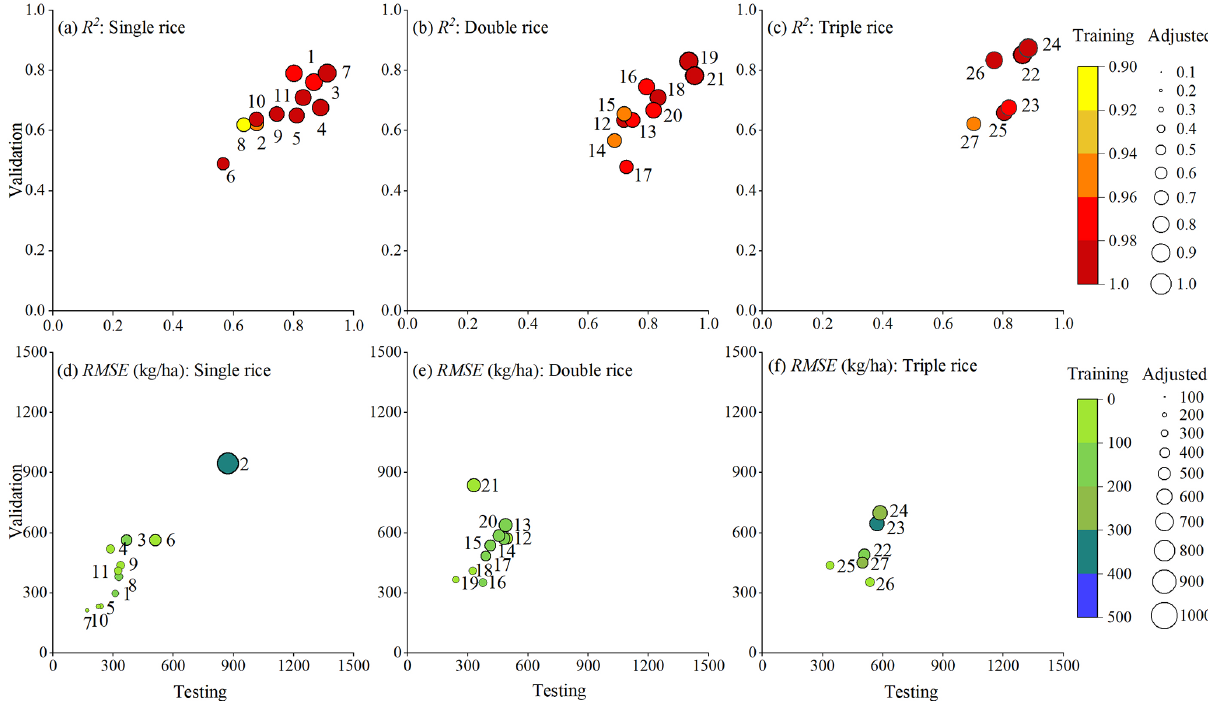
Figure 3. Accuracy, with respect to the R 2 (a–c) and RMSE (d–f) of the estimated yields for seasonal rice in each region. The color of the dots indicates different training accuracy ranks. The testing accuracy is given on the x axis, and the validation accuracy is given on the y axis. The size of dots represents the adjusted accuracy. Note that the numbers beside each dot represent each case shown in Fig. 1b.